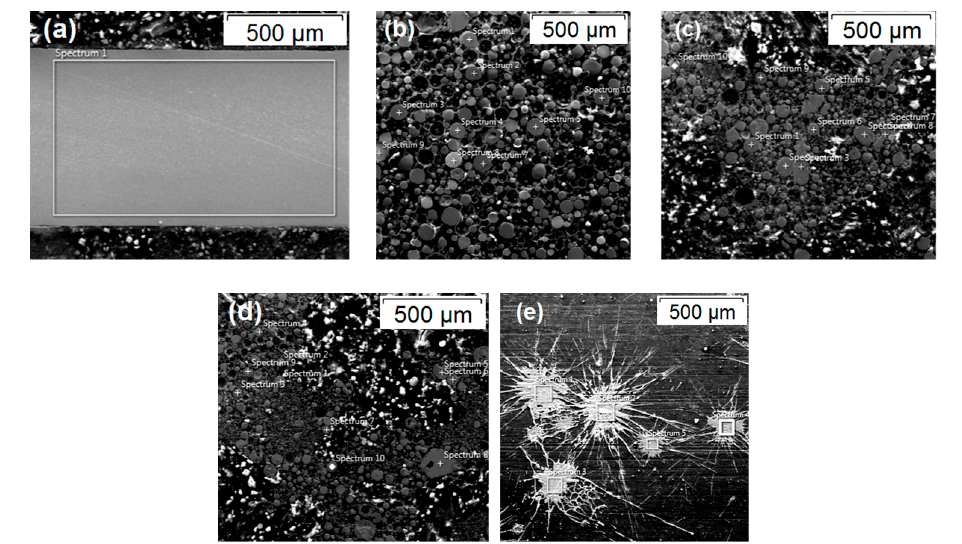
Figure 2. Images of the location where the chemical composition analyses were realized. ( a ) Wire of 309L, the rectangle Spectrum 1 delimits the area for the Energy-Dispersive Spectroscopy (EDS) measurement; ( b ) FeMnCrSiNi, ( c ) 410NiMo, and ( d ) 309L particles, the points spectrum indicate in which particles the EDS was done; ( e ) 70S-6 lamellae deposited in flat glass, the rectangles’ spectrum delimit the area where the EDS was done in each splat.